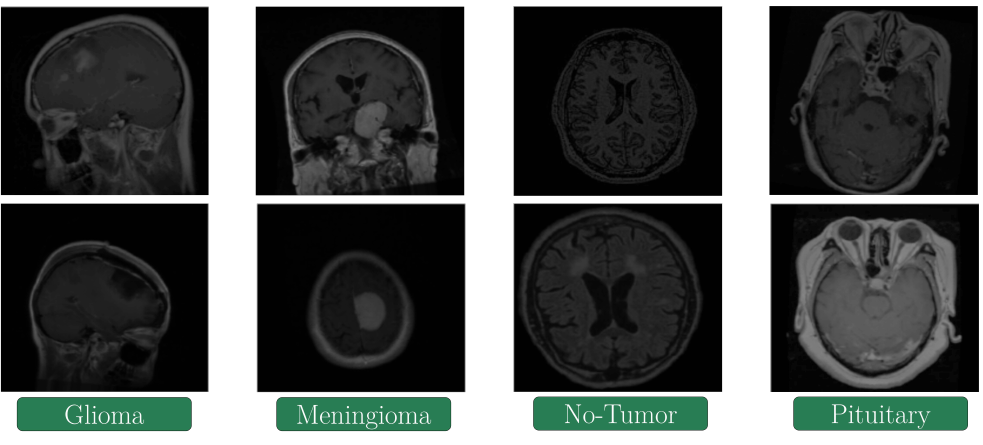
Figure 8. Examples of preprocessed